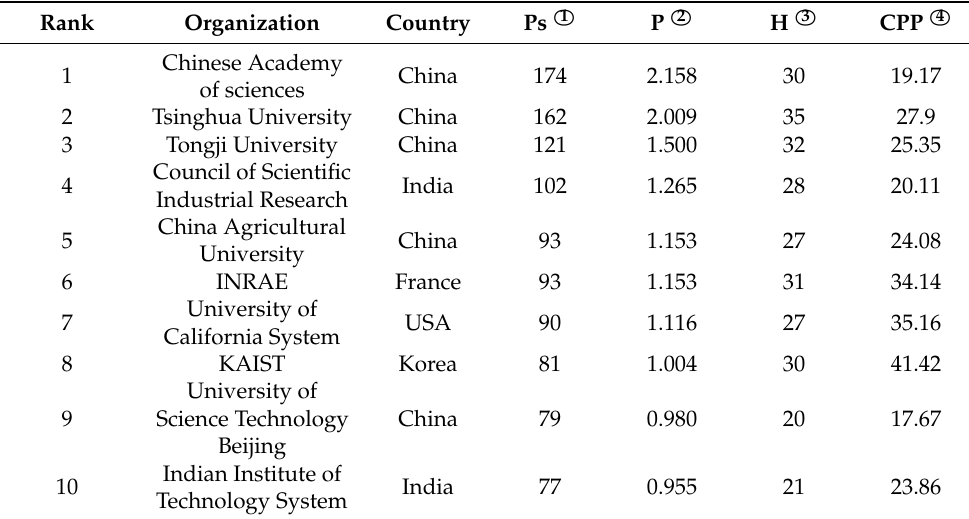
Table 1. Top 10 organizations with the most publications in food waste studies. Rank